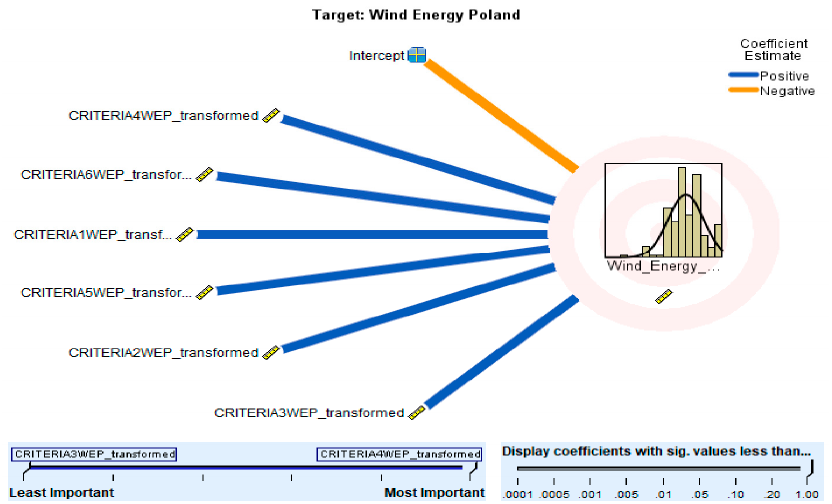
Figure 8. WE Poland GCV Criteria. Source: ALM Analysis SPSS by Author.